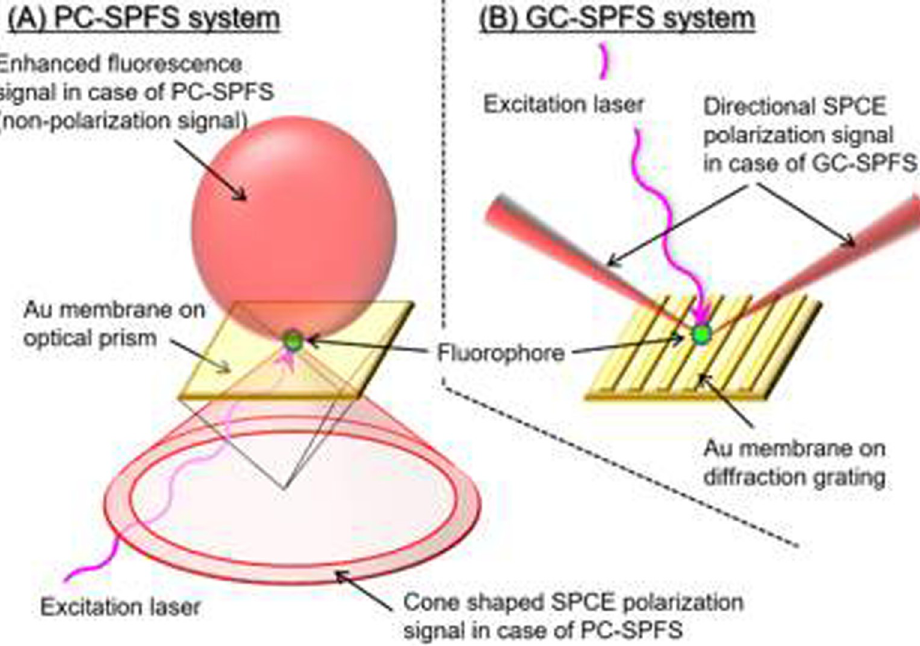
Fig 1. Schematic views of principle of surface plasmon coupled emission (SPCE). (A) SPCE in prism-coupled surface plasmon field-enhanced fluorescence spectroscopy (PC-SPFS) and (B) SPCE in grating-coupled surface plasmon field-enhanced fluorescence spectroscopy (GC-SPFS). SPCE integrates fluorescence and plasmonics, and the SPCE signal has direction and polarization. The directional SPCE polarization signal in GC-SPFS is much higher than cone-shaped SPCE polarization signal in